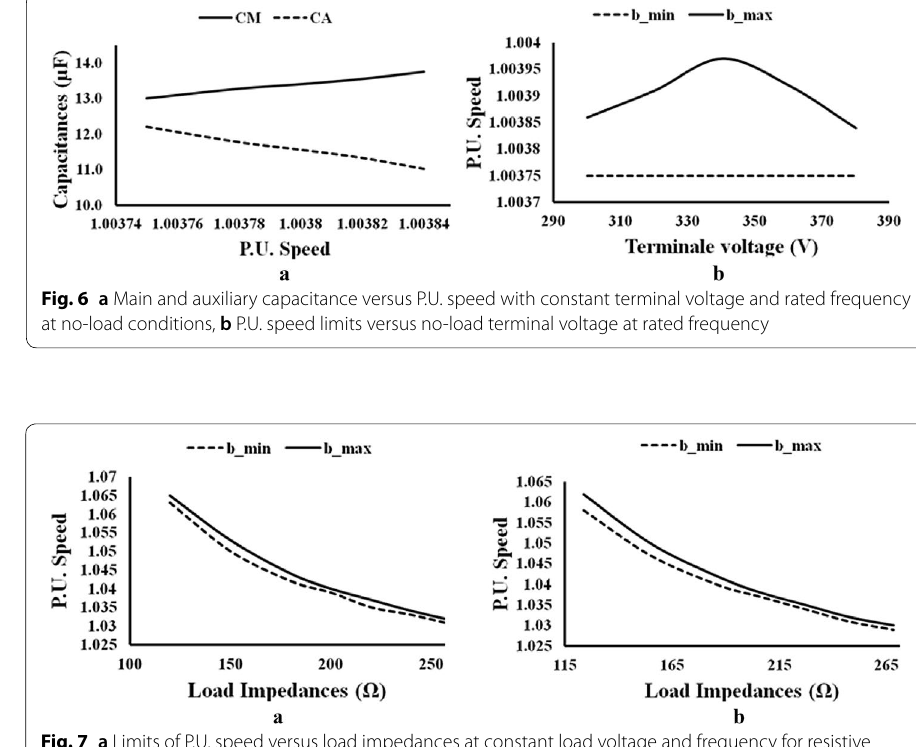
Fig. 7 a Limits of P.U. speed versus load impedances at constant load voltage and frequency for resistive loads, b limits of P.U. speed versus load impedances with 0.97 power factor at constant load voltage and